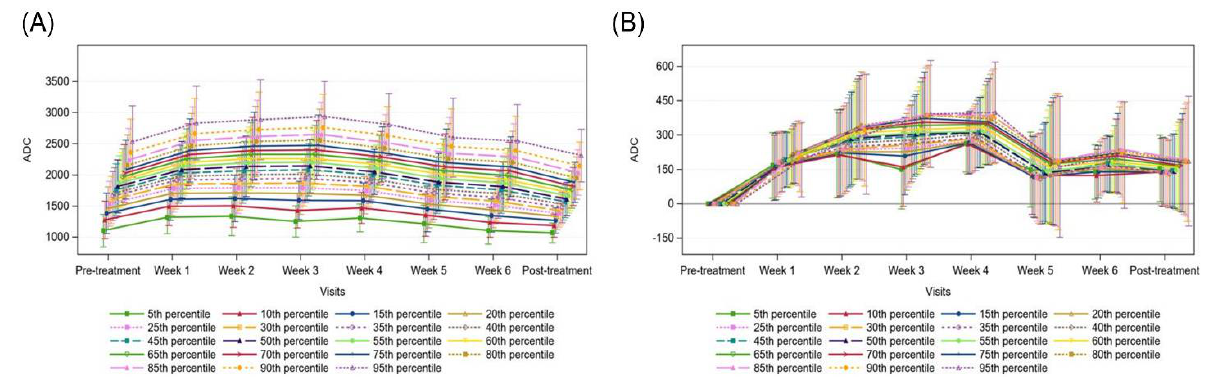
Figure 5. Absolute apparent diffusion coefficient (ADC) measurements ( A ) and mean ADC change from pre-treatment ( B ) for the involved nodes, with 95% confidence intervals.